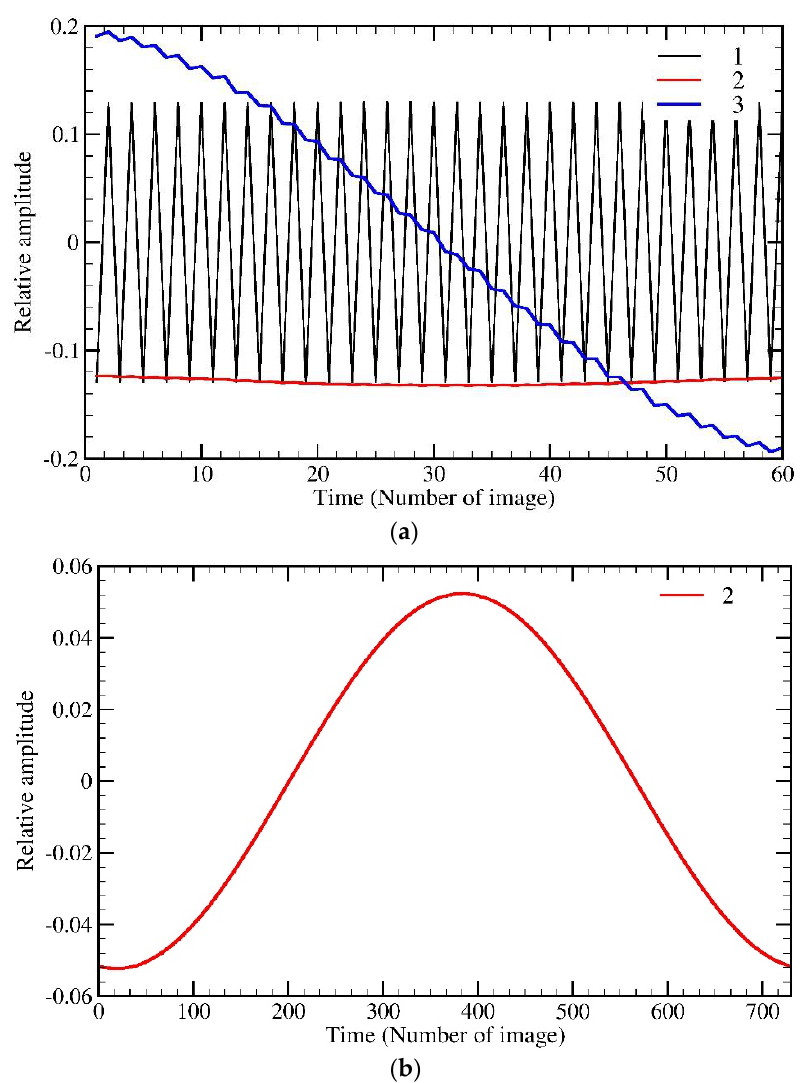
Figure 10. SSA T-EOFs of components 1, 2, and 3 values with image window size 60 ( a ), and SSA T-EOFs of components 3 with image window size 730 ( b ).